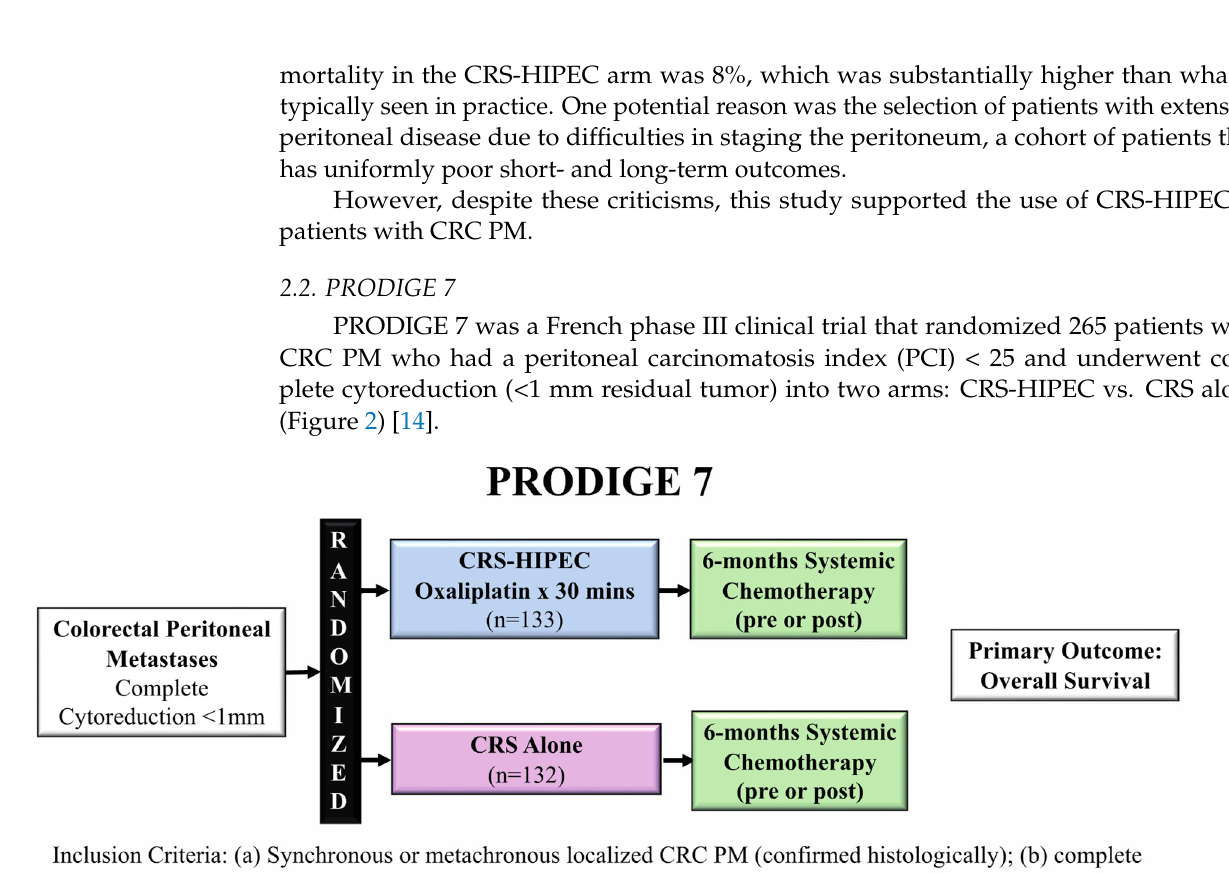
Figure 2. PRODIGE 7 trial schem comparing CRS-HIPEC to CRS alone evaluating overall